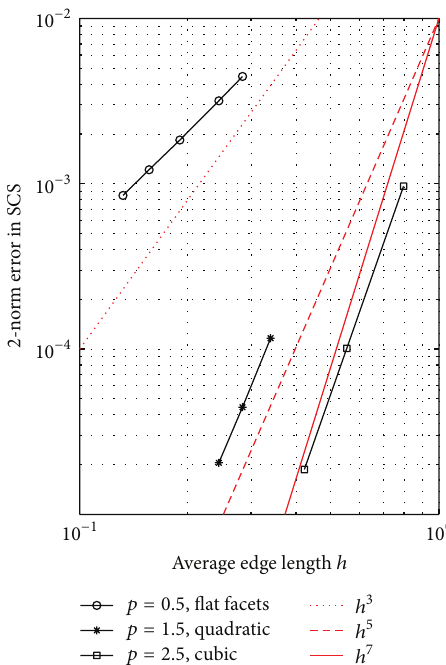
Figure 9: Error in the SCS versus the average edge lengths in the models, for the same torus used in Figures 7 and 8. EFIE results are reported for a flat-faceted model used in conjunction with 𝑝 = 0.5 basisandtestfunctions,aquadratic-curvedmodelusedwith 𝑝 = 1.5 functions, and a cubic-curved model used with 𝑝 = 2.5 functions. Ideal asymptotic rates of 𝑂(ℎ 3 ) , 𝑂(ℎ 5 ) , and 𝑂(ℎ 7 ) are shown for comparison.